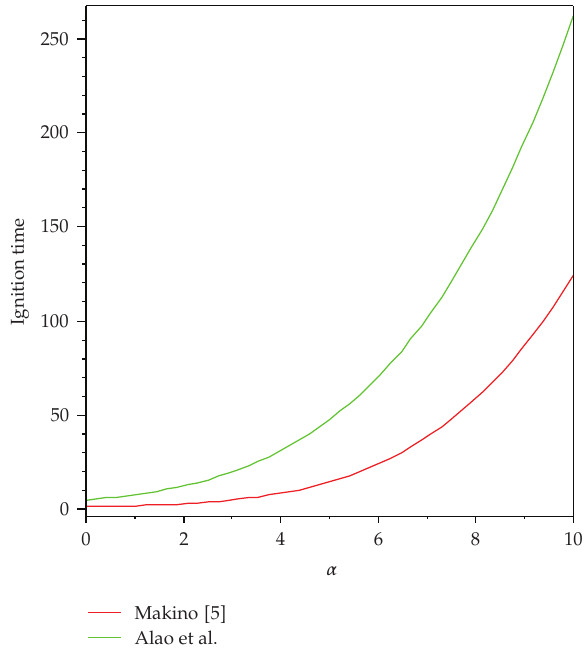
Figure 1: Comparison of ignition times: plot of (cid:3) 6 (cid:6) in Makino (cid:4) 5 (cid:5) and (cid:3) 3.1 (cid:6) in present study.